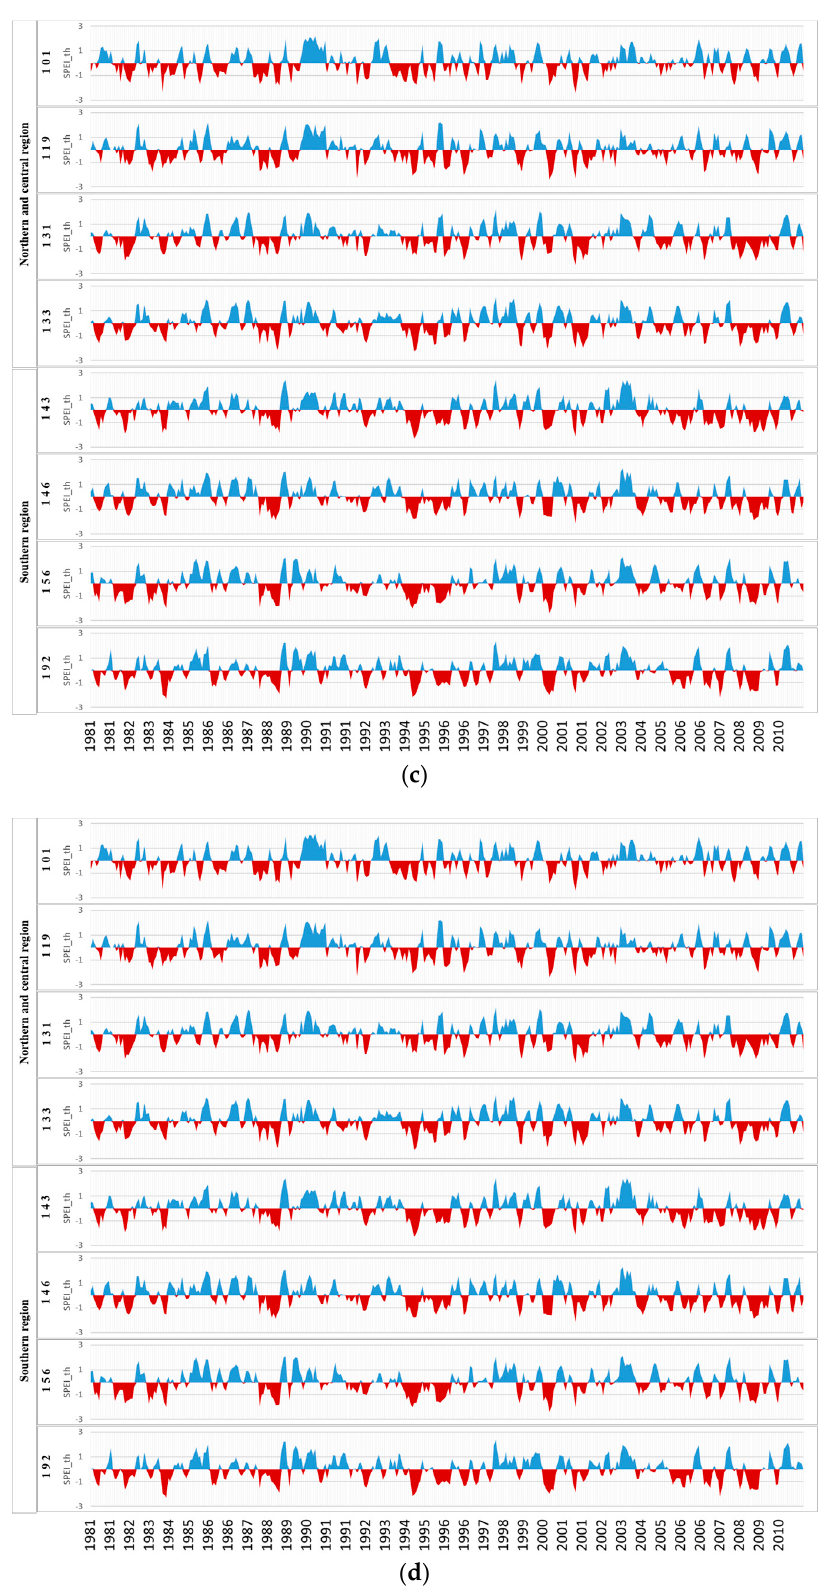
Figure 3. 1- and 3-month SPEIs at 8 stations from 1981 to 2010. ( a ) 1-month SPEI_th, ( b ) 1-month SPEI_pm, ( c ) 3-month SPEI_th, ( d ) 3-month SPEI_pm.